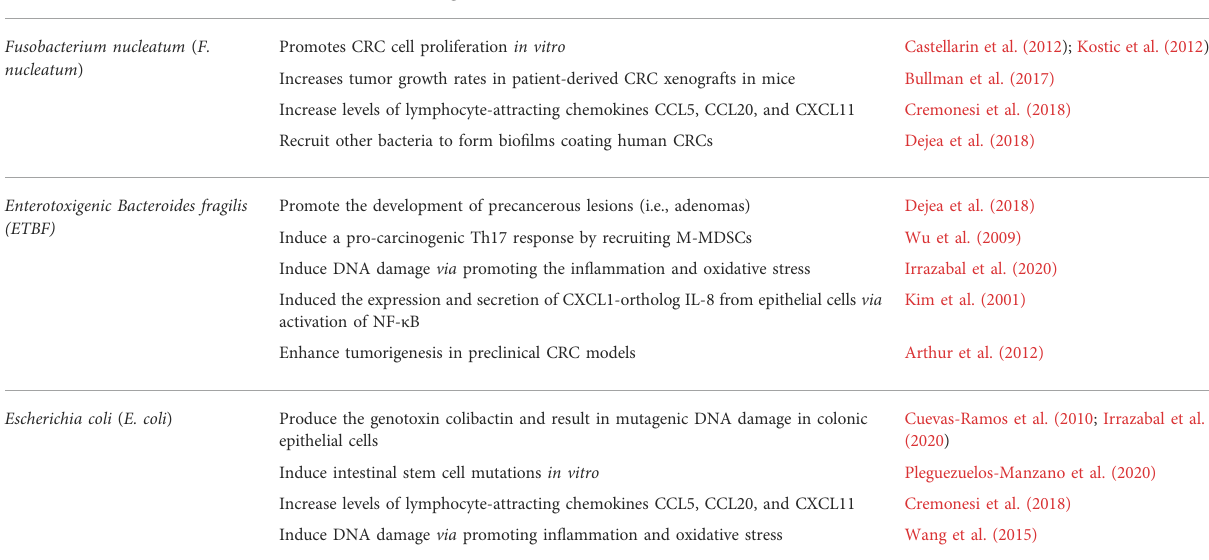
TABLE 1 CRC-associated bacteria and their effects on